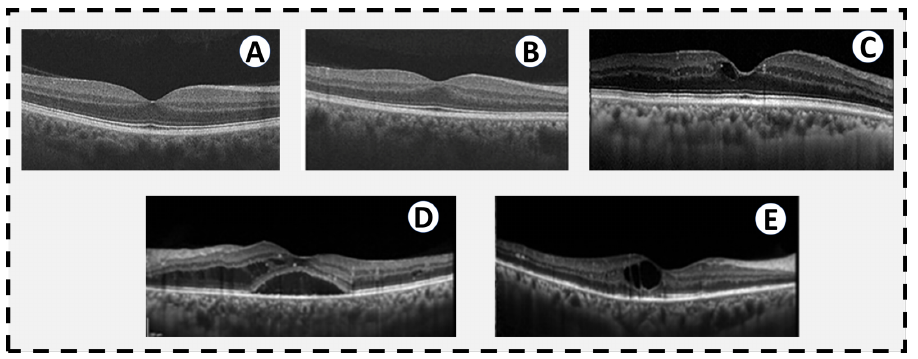
Figure 3. OCTs of different levels of diabetic retinopathy. ( A ) A normal OCT in a patient without diabetes. ( B ) OCT from a diabetic patient without DR by traditional historical criteria, but subtle changes in thickness and reflectivity of some of the retinal layers. ( C ) Mild NPDR with a small cystic space at the fovea. ( D ) Severe NPDR with diffuse diabetic macular edema extending into the subretinal space. ( E ) PDR with a large central cystic space and intraretinal hyperreflective spots temporally indicative of intraretinal lipid exudates. There is mild thinning of the temporal inner retina consistent with ischemia seen in PDR.